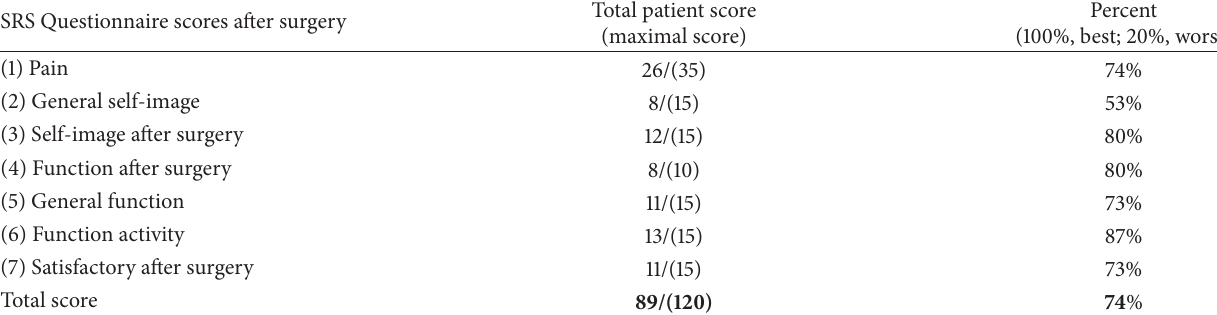
Table 2: SRS Questionnaire score after